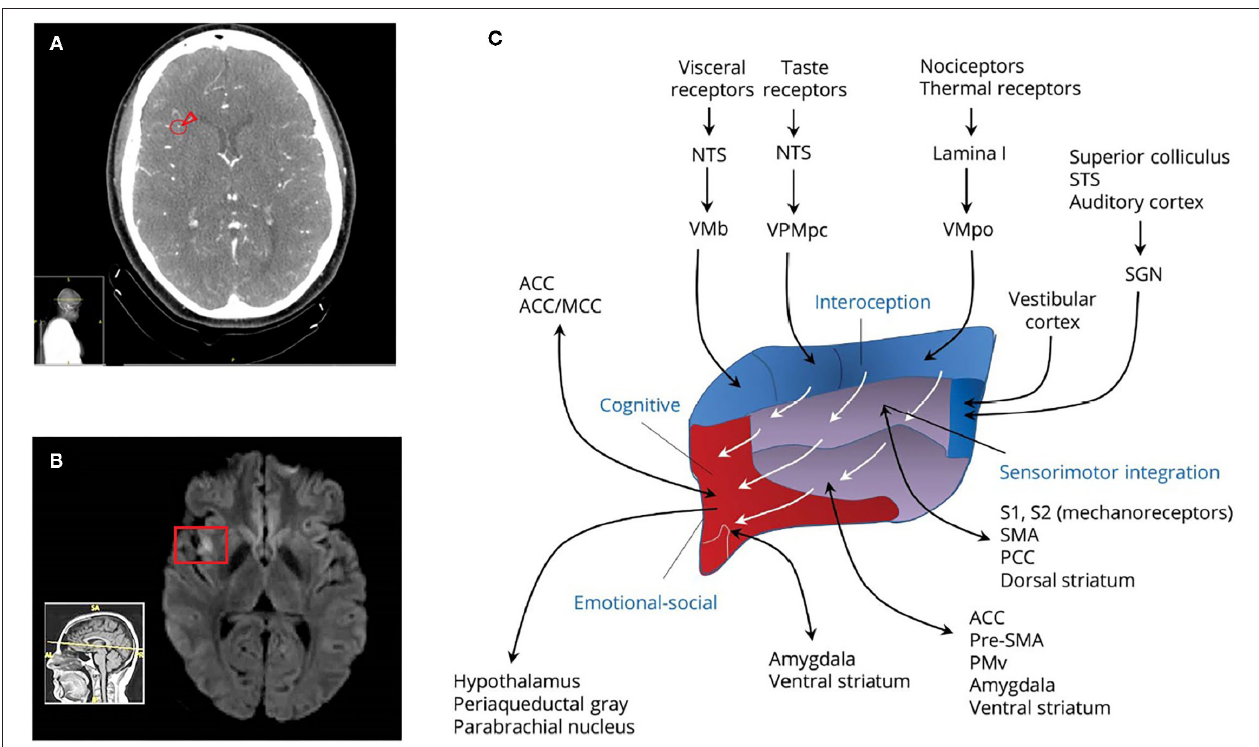
FIGURE 1 | (A) Computed tomography angiography indicating short segment occlusion versus critical stenosis in the M2/M3 branch vessels of the rMCA. (B) Noncontrast MRI scan revealing a small evolving region of ischemia in the right insula adjacent to lesions in the CTA. (C) Complex interconnectivity of the insula with multiple circuits conveying interoceptive (blue area) sensorimotor (purple area), cognitive, emotional, and social functioning (red area). Reproduced and edited from Ghaziri et al. (11) with permission from Wolters Kluwer Health, Inc. ACC, anterior cingulate cortex; MCC, medial cingulate cortex; NTS, nucleus of the solitary tract; PPC, posterior parietal cortex; preSMA, presupplementary motor area; PMv, ventral premotor cortex; S1, somatosensory area 1; S2, somatosensory area 2; SGN, suprageniculate nucleus; SMA, Supplementary motor area; STS, superior temporal sulcus; VMb, ventromedial basal nucleus; VMpo, ventromedial posterior nucleus; VPMpc, ventral posteromedial